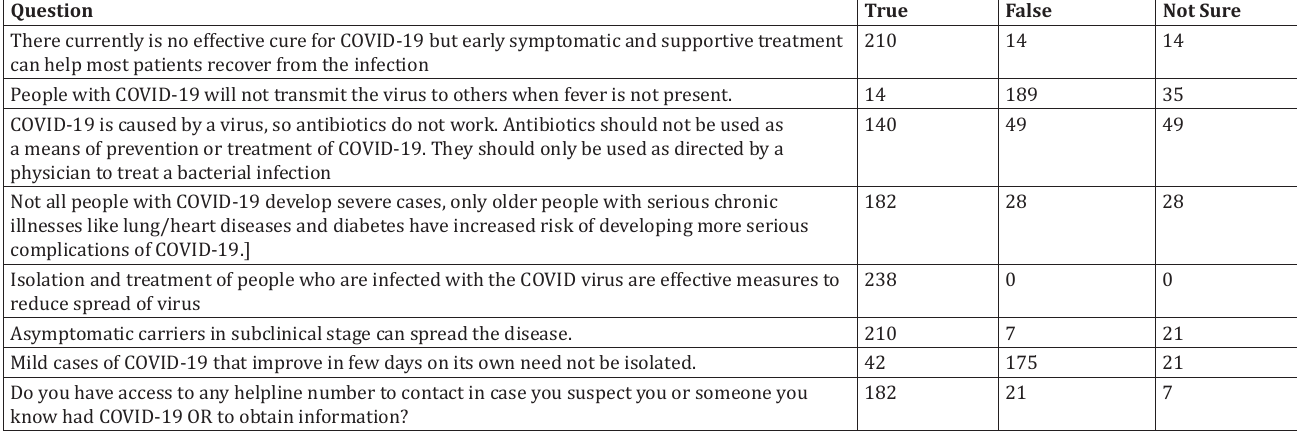
Table 3 Response to knowledge aspect for Covid-19 infection with once choice option